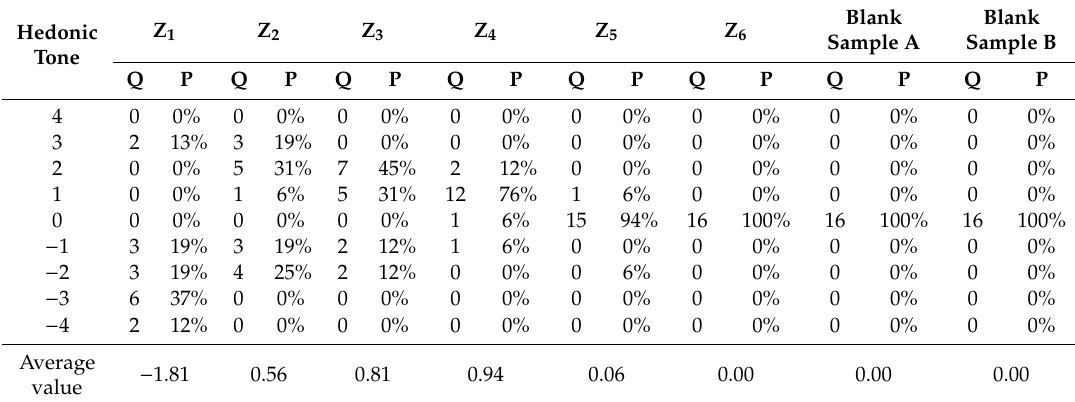
Table 3. The result of the hedonic tone evaluation for limonene; the OC of the original sample is 7413 OU E · m − 3 . The dilution times from Z 1 to Z 6 are respectively 0, 10, 30, 100, 300 and